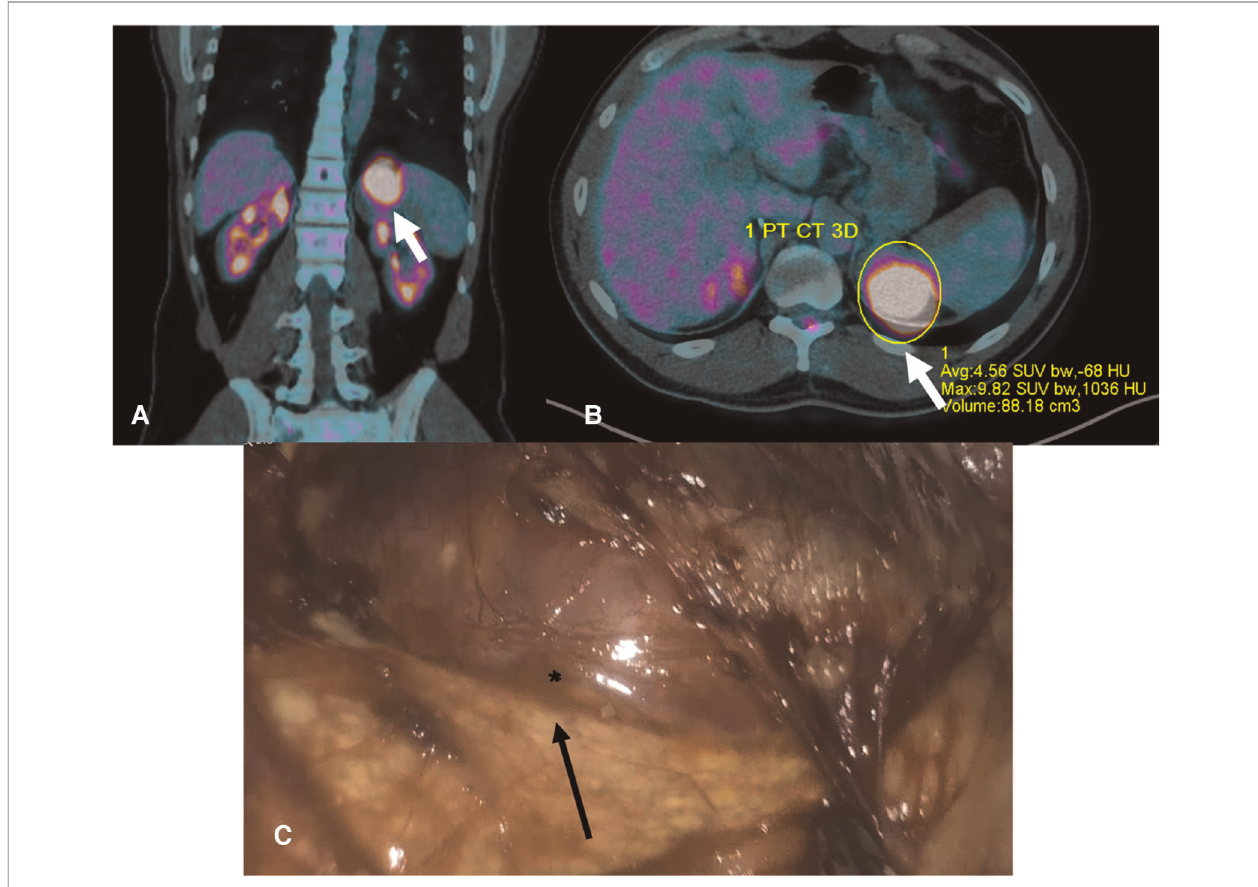
FIGURE 3 | ( A,B ). PET scan 2020- The images show a well-de fi ned lesion (arrow) involving the left adrenal region that has a SUV average of 4.56 with an average -68bHU; SUV average is higher than the liver SUV, thus suggesting a malignant lesion. ( C ). Intraoperative picture. The normal adrenal gland is indicated by the arrow, whereas the surface of the oncocytoma by the